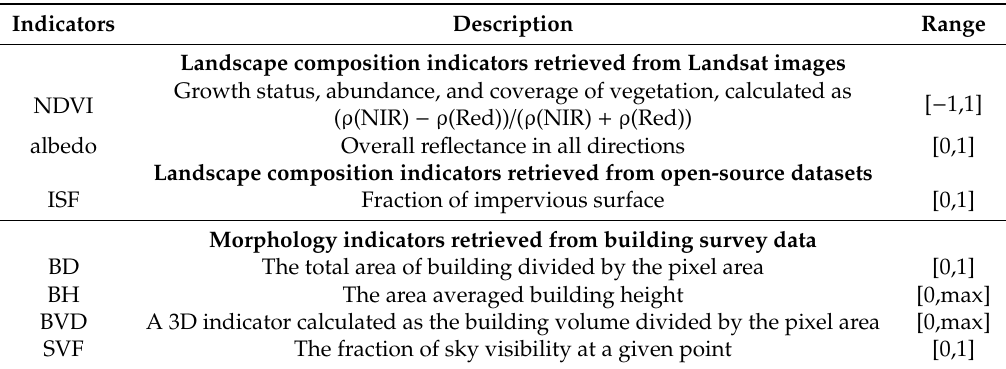
Table 1. Comprehensive information about the selected